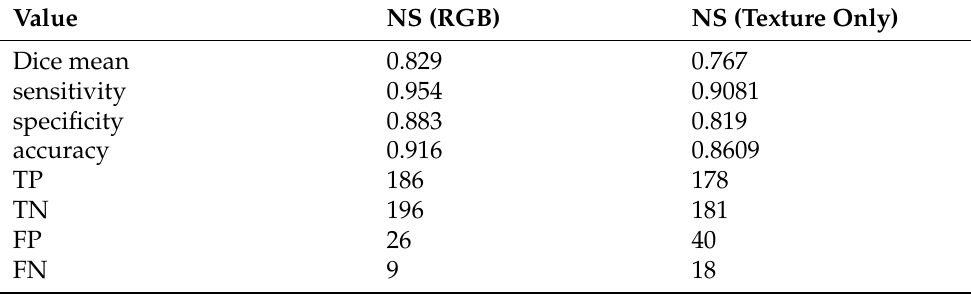
Table 5. Nickel Silver material segmentation